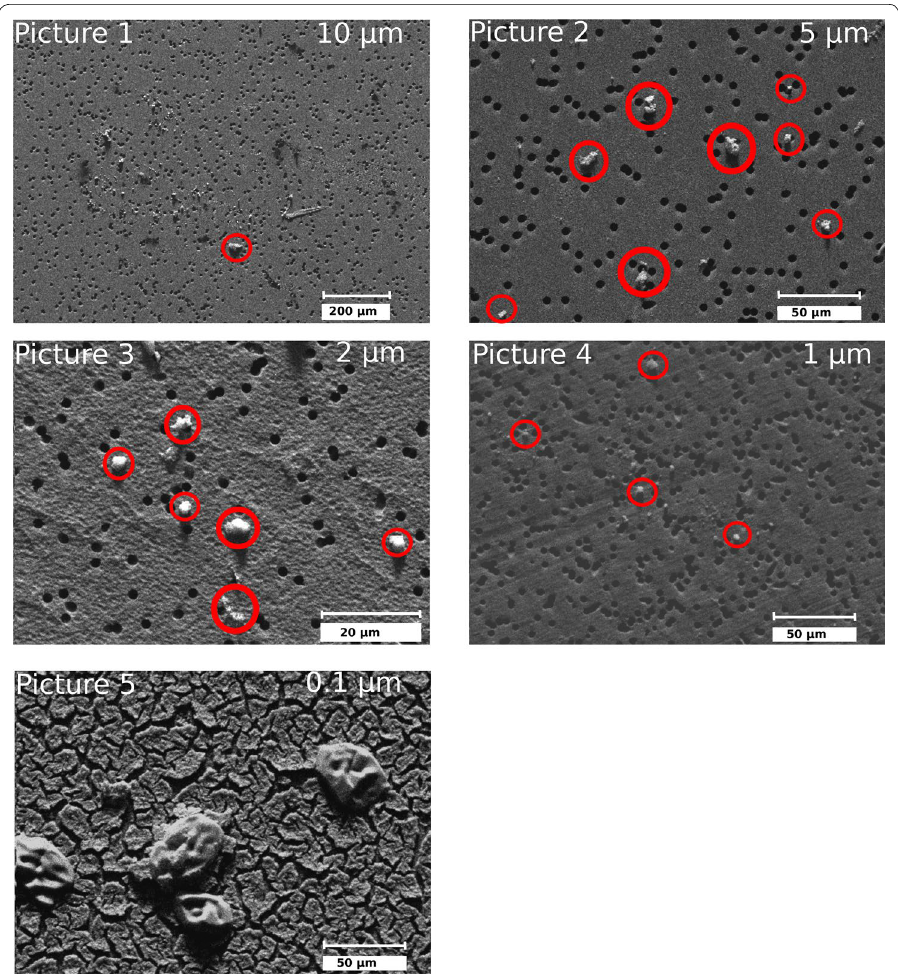
Fig. 7 Overview of particles collected at the field site (here, at an injection temperature of 90 ◦ C ): low particle load on the filters with pore sizes of 10 µ m to 1 µ m (see picture 1–4) due to the CO 2 addition. Only filters with 0.1 µ m pore sizes had a significant particle load (see picture 5). Mostly rounded particles are visible at pore sizes of 1– 10 µ m (see red circles). Pore sizes of 0.1 µ m showed a muddy matrix, and no crystals can